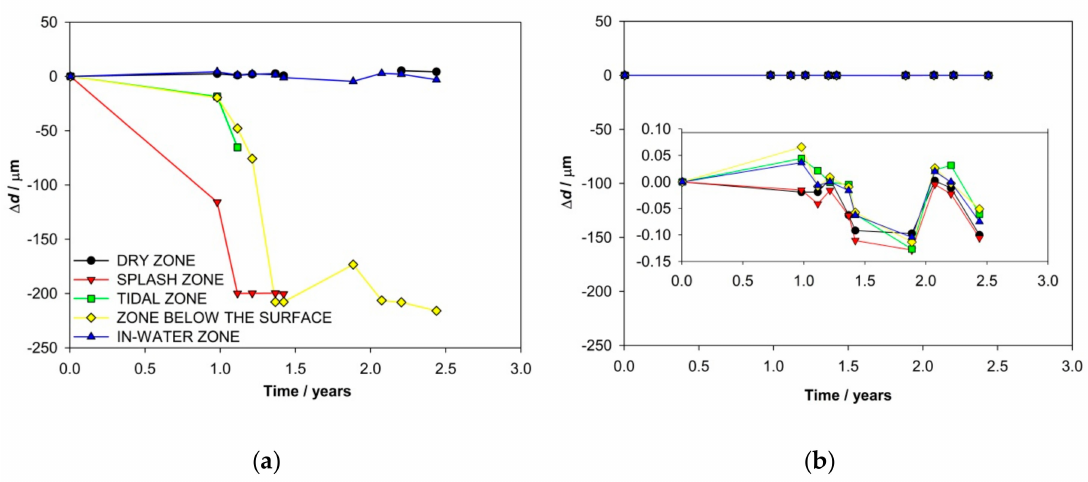
Figure 3. Thickness reduction of ER probes in di ff erent zones of exposure made of ( a ) carbon steel (column C11) and ( b ) stainless steel (column